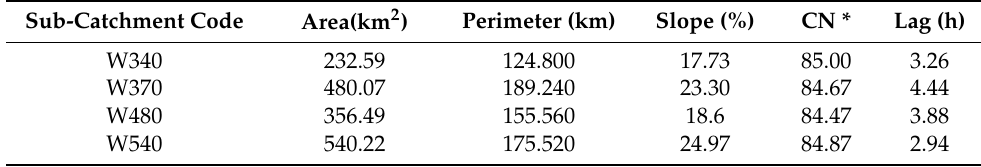
Table 2. Physiographic characteristics of the